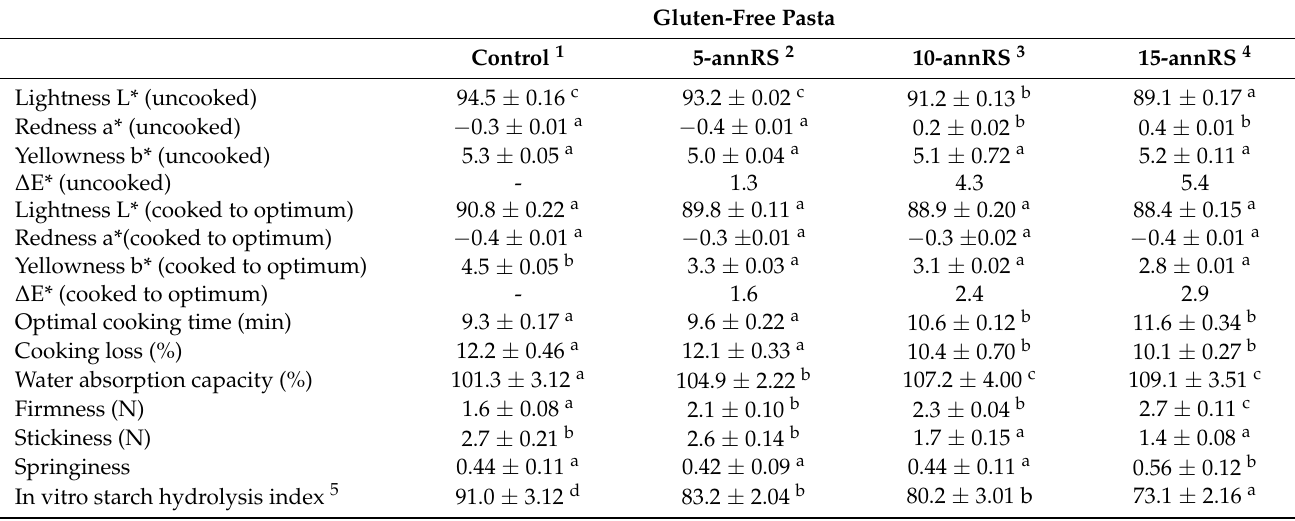
Table 2. Quality parameters, texture analysis, and in vitro starch hydrolysis index of gluten-free macaroni containing resistant starch from annealed white sorghum starch